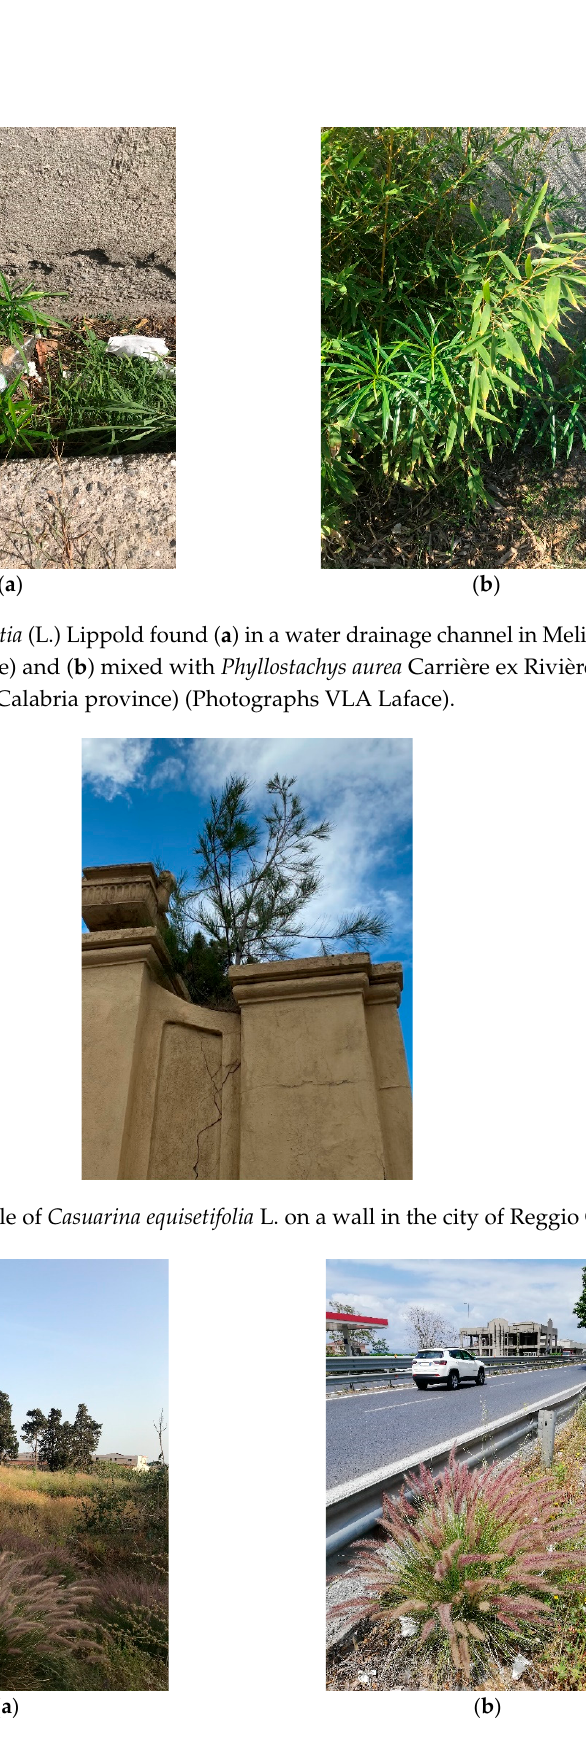
Figure A5. Cenchrus setaceus (Forssk.) Morrone widespread both ( a ) in a natural field in Saline Joniche (Reggio Calabria province) (Photograph VLA Laface) and ( b ) along a communication route in Reggio Calabria (Reggio Calabria province) (Photograph CM Musarella).